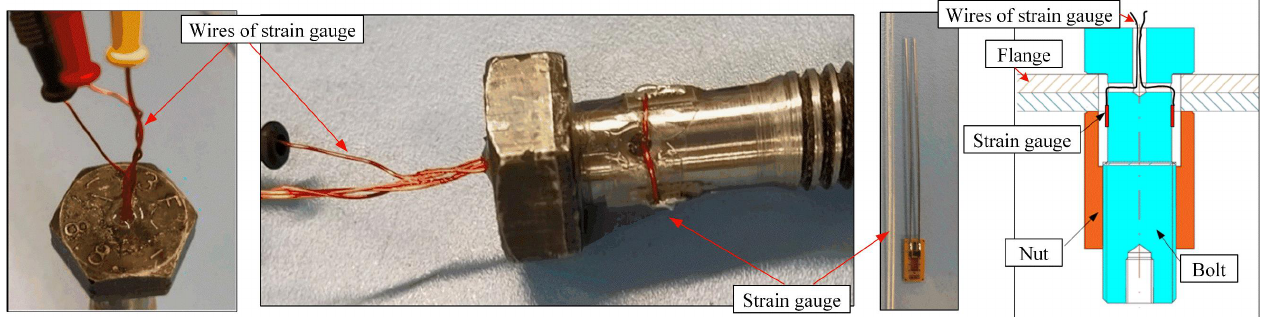
Figure 7. The strain gauges glued on the bolt for the axial tension measurement.